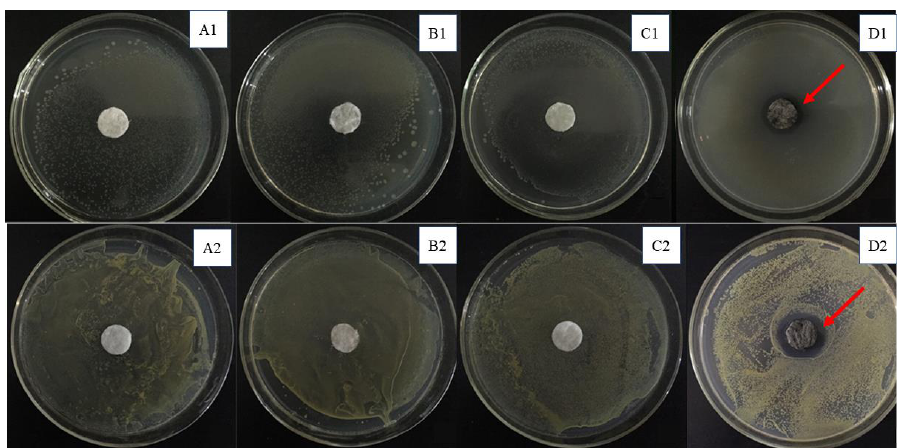
Figure 8. Inhibition of Escherichia coli (1) and Staphylococcus aureus (2) by the cotton at different stages of preparation: ( A ) pristine cotton, ( B ) Cotton-Br, ( C ) Cotton-METAC, and ( D ) Cotton-Ag.